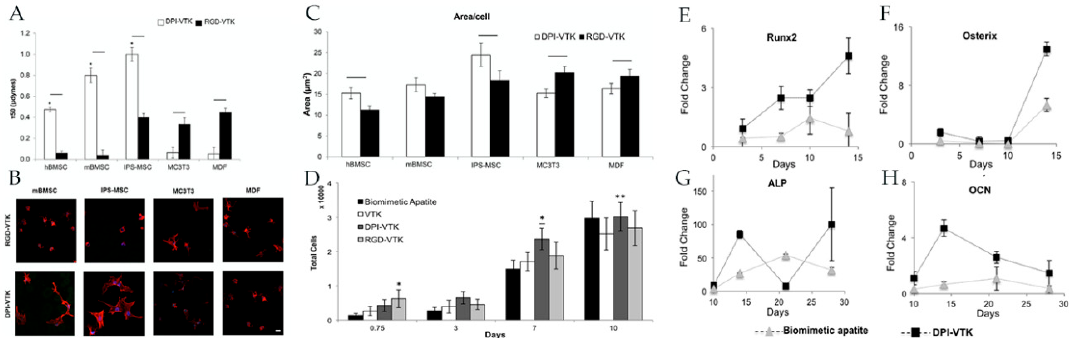
Figure 7. ( A ) Half-cell detachment force ( τ 50) measured from peptide-coated apatite films of human bone marrow stem cells, murine bone marrow stem cells (mBMSCs), induced pluripotent stem cell (iPS)-derived mesenchymal stem cells (MSCs), pre-osteoblastic MCTC3s, and murine dermal fibroblasts (MDFs). ( B ) Confocal microscopy images taken at 40x show increased spreading of mBMSCs and iPS-MSCs on DPI-VTK-coated apatite films and increased spreading of MCTC3 and MDFs on RGD-VTK-coated apatite films. ( C ) Quantitative analysis of cell spreading via ImageJ on peptide-coated apatite films. ( D ) Total number of cells over time, reaching saturation at day 10. * denotes significance compared to apatite control and tissue culture polystyrene (TCPS). * denotes significance compared